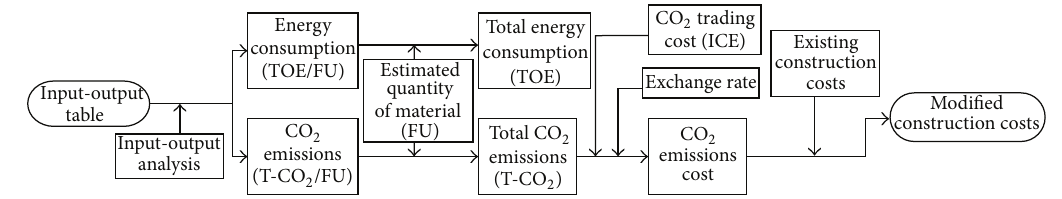
Figure 1: Flowchart for estimation of energy consumption and CO 2 emissions and modified construction